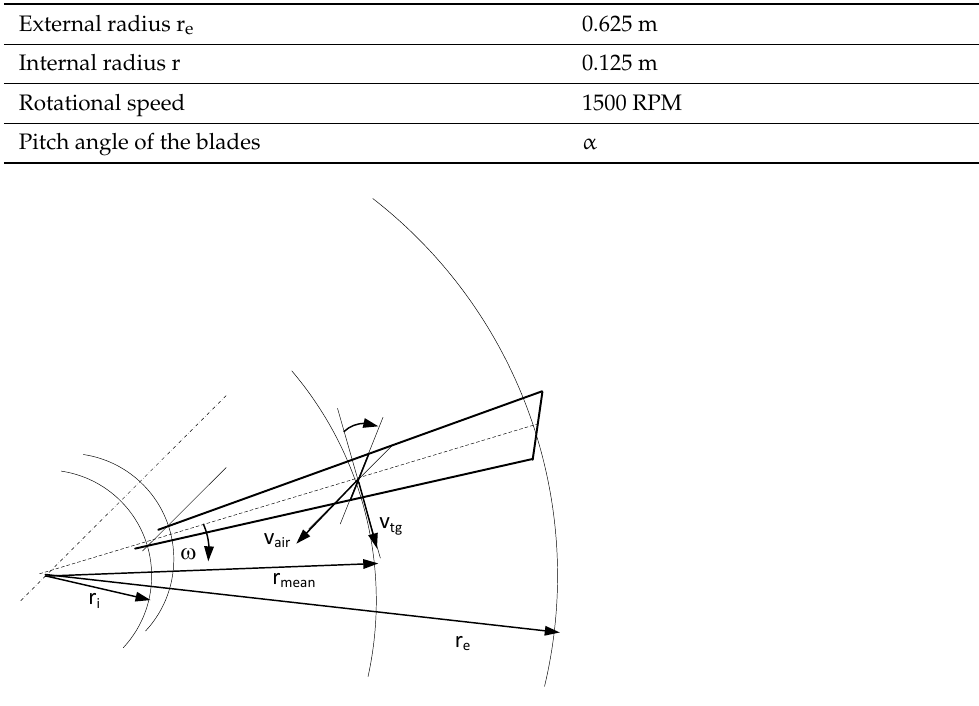
Figure 6. Model and parameters of the fan’s blades .